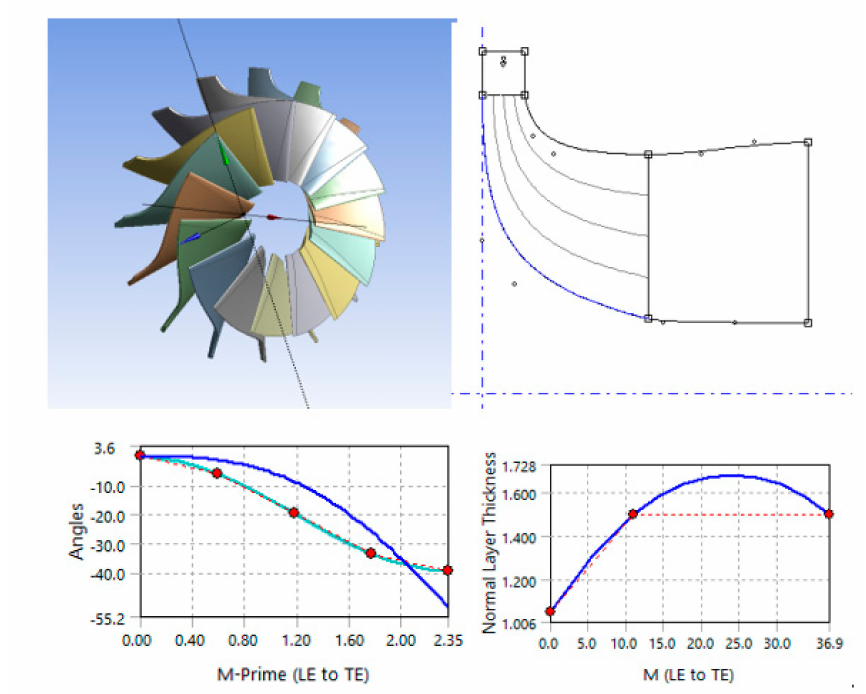
Figure 6. 3D geometry of the optimized model, meridional view and its angle thick distributions.